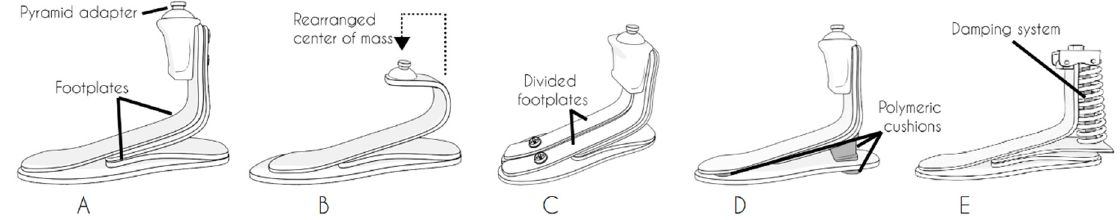
Figure 8. ( A ) General form of ESAR prosthesis, ( B ) Modified ESAR prosthesis, ( C ) ESAR with split plates, ( D ) ESAR prosthesis with cushions, ( E ) ESAR with damping system.